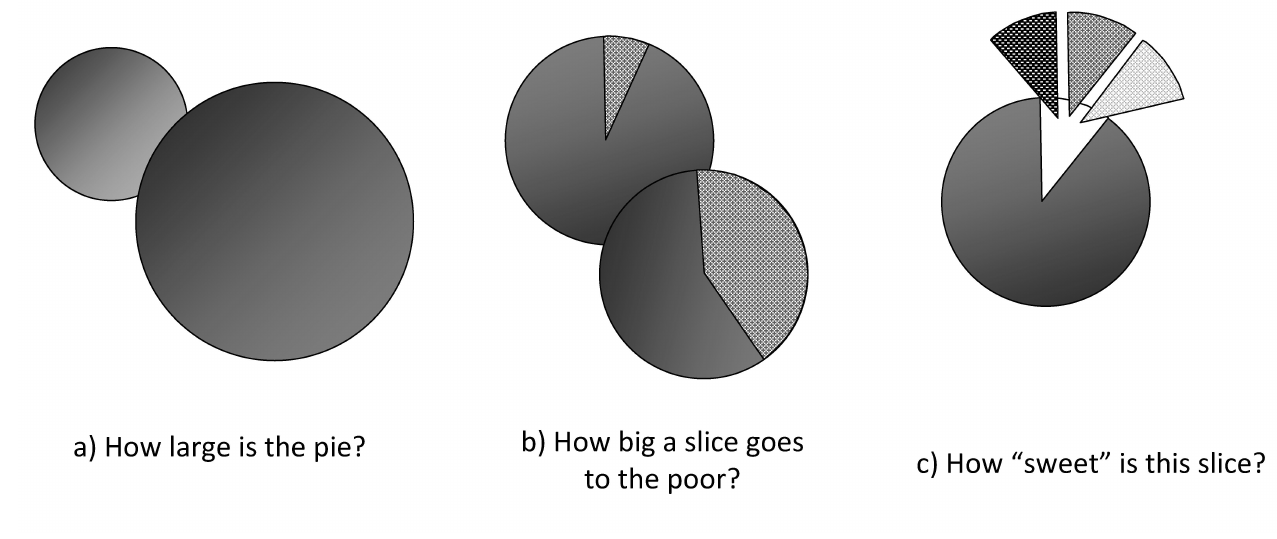
Fig. 1. Conceptual representation of the key factors influencing the potential of payment for ecosystem services to benefit low-income people. (A) Total size of PES markets, (B) degree to which low-income people can participate in these markets as sellers of ecosystem services, (C) degree to which participants actually